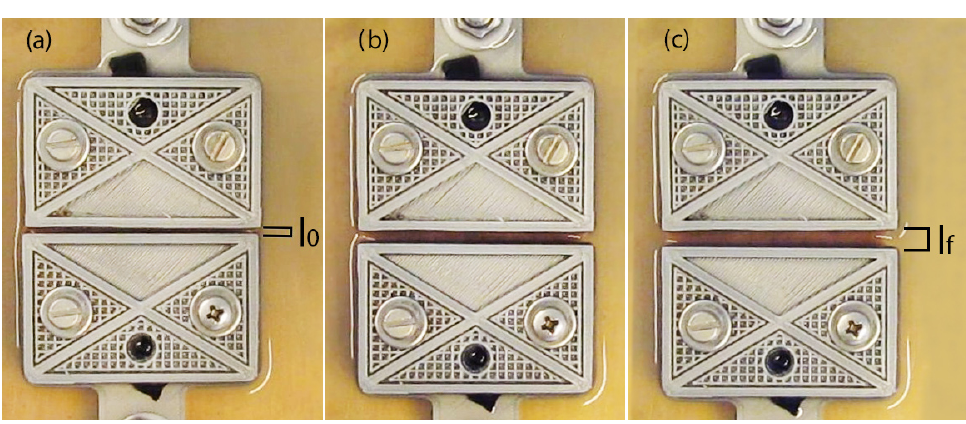
s ; l = l 1 mm ; ( b ) intermedi- 0 0